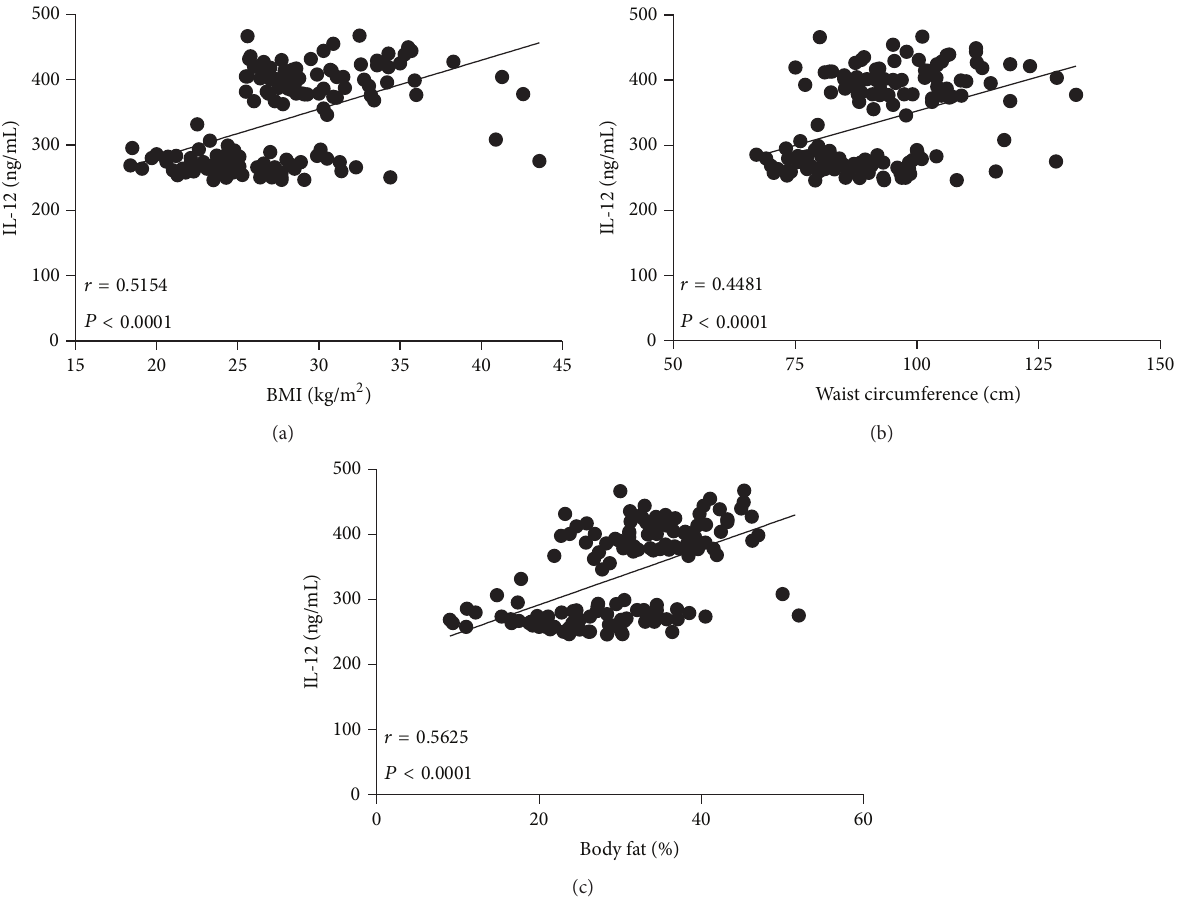
Figure 2: Relationship between serum levels of IL-12 and anthropometric parameters of obesity. Serum IL-12 values were positively associated with body mass index (BMI) (a), waist circumference (b), and body fat percentage (c). Coefficients ( r ) and P values were calculated by the Spearman’s correlation model. The correlation level was considered significant when 𝑃 < 0.05